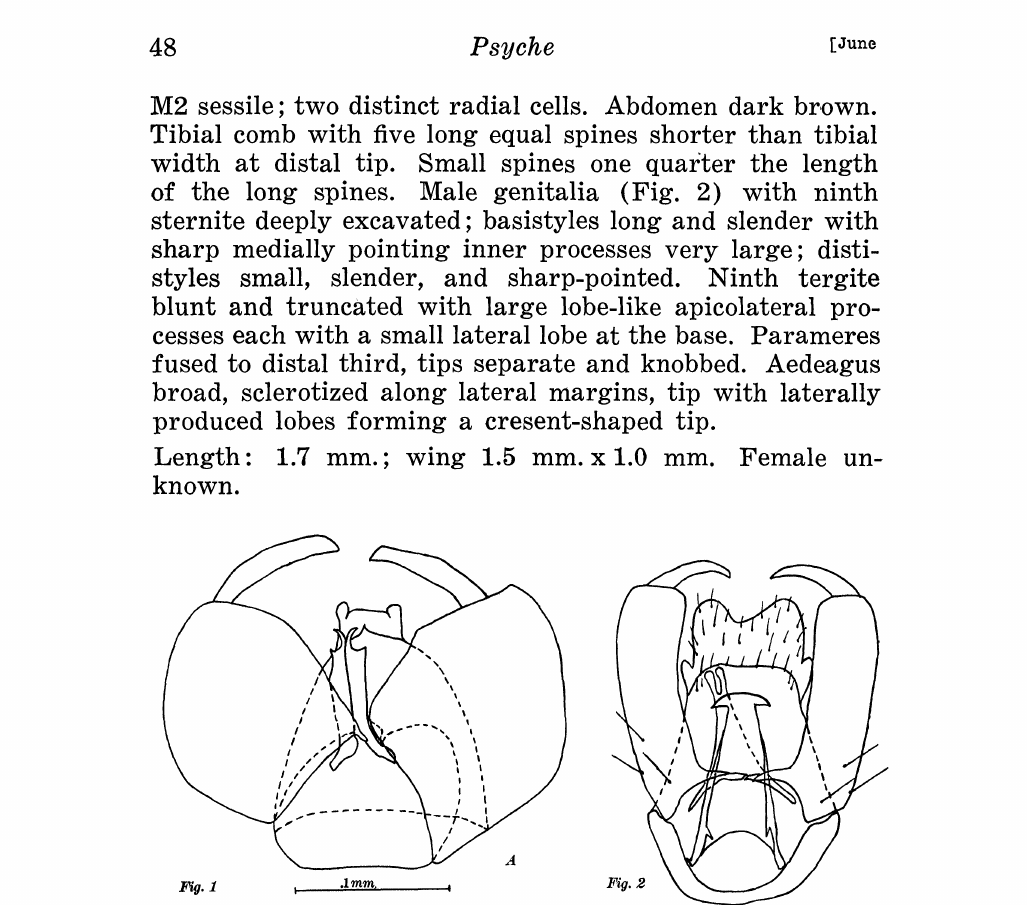
Fig. 1. A. Ventral view of male genitalia of Helea (Isohelea) serrata n. sp. B. Aedeagus. Fig. 2. Ventral view of male genitalia of Johann- seno,,myia smithi n.